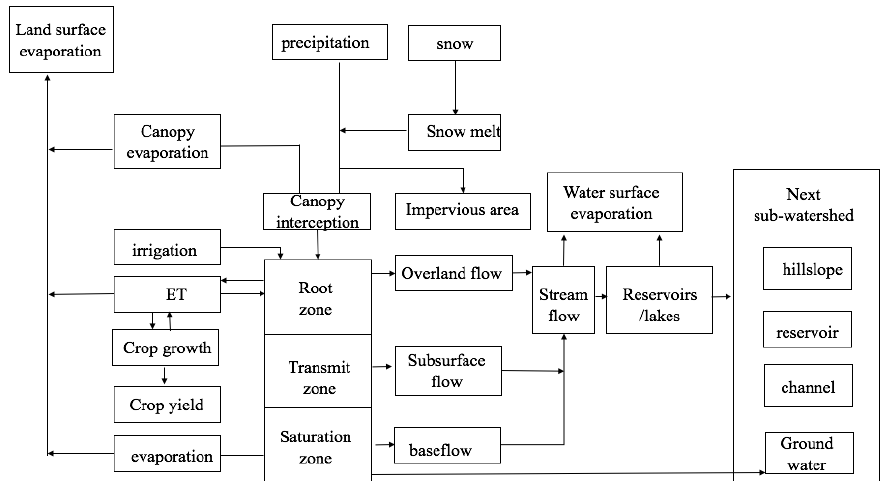
Figure 3. HIMS model customization (Wang et al. [1]).